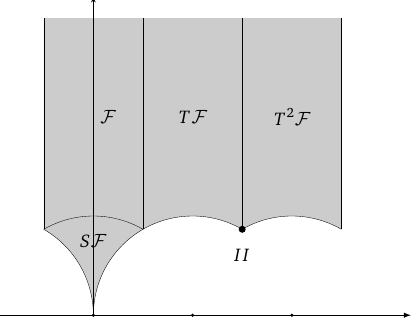
= 1 theory. The marked point τ = 2 + e 2 i π/ 3 f